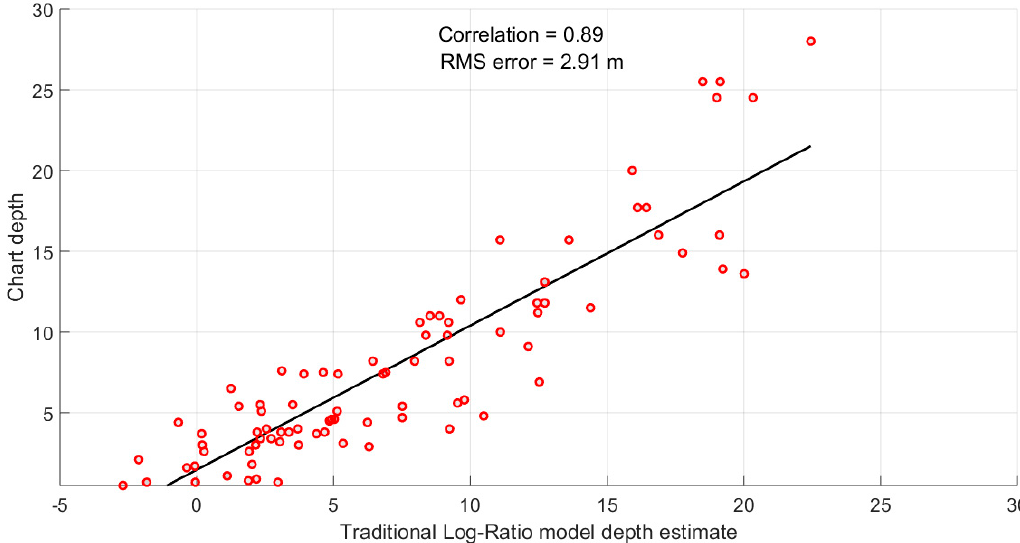
Figure 9. The correlation between modelled/validated depth estimates and the “truth” nautical chart depths for the 90 collocated stations using the Stumpf log-ratio model.